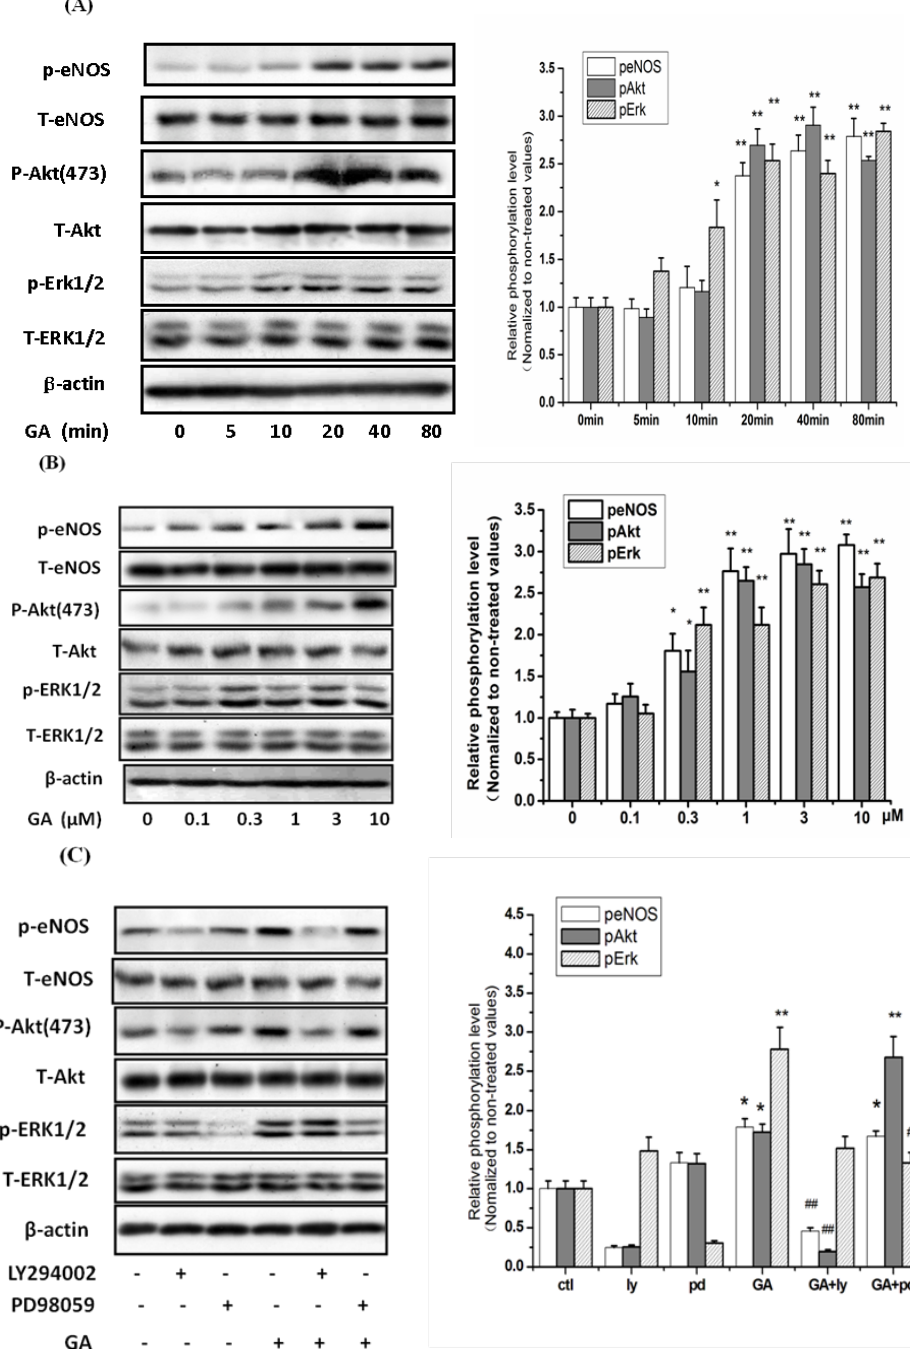
Figure 5. GA activated the phosphorylation of eNOS, Akt and ERK1/2. RGC-5 cells were treated with 10 μM GA for 5–80 min or 0.1–10 μM GA for 20 min. The phosphorylation of eNOS, Akt and ERK1/2 were determined by Western blotting with anti-phospho-Akt (Ser473), anti-phospho-ERK1/2, anti-phospho-eNOS (Ser1177), respectively, using β-actin as control. GA time-dependently induced the phosphorylation of Akt, eNOS, and ERK1/2 in RGC-5 cells. ( A ) Time course; ( B ) Dose course; ( C ) The effects of pathway inhibitors on the GA-activated phosphorylation of Akt, eNOS and ERK1/2. Results represent prototypical experiments replicated at least three times. * p < 0.05, ** p < 0.01, && p < 0.01 vs. control group; ## p < 0.01 vs. GA